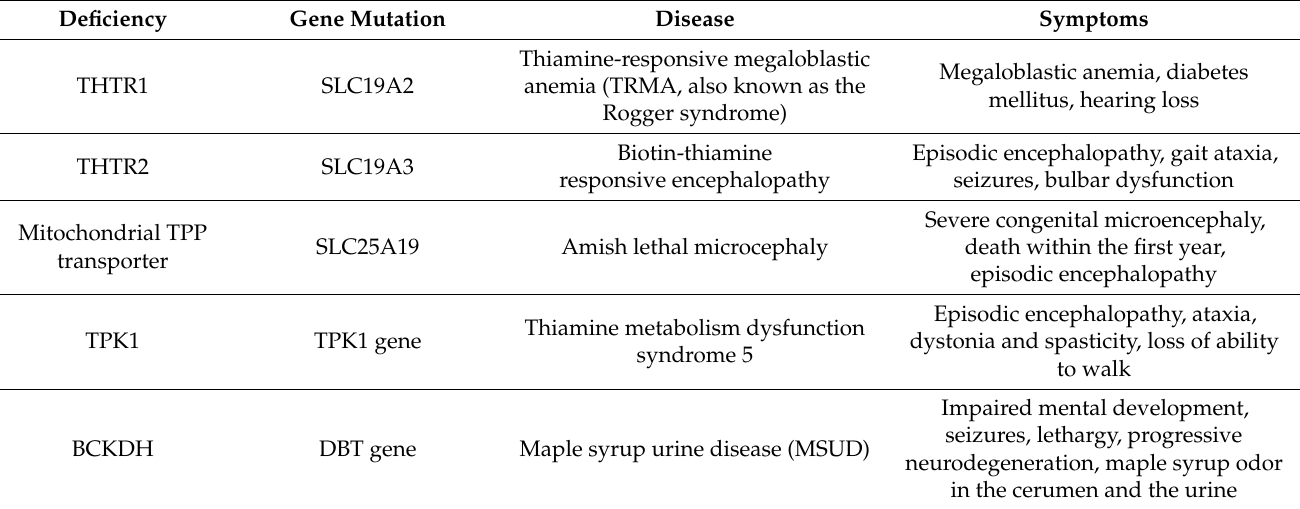
Table 2. Genetic defects in thiamine transport and